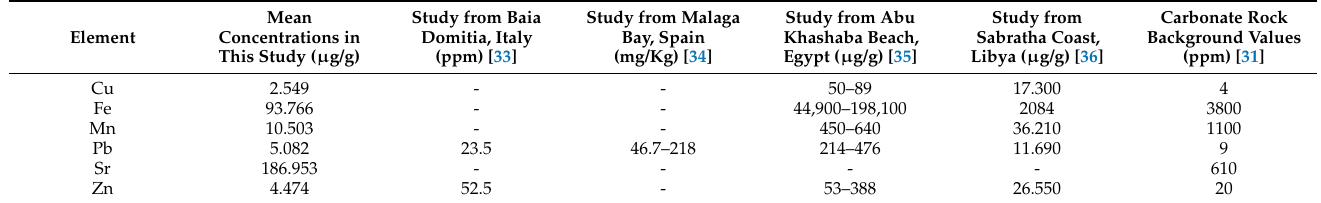
Table 7. Concentrations of heavy metals in sand in different Mediterranean